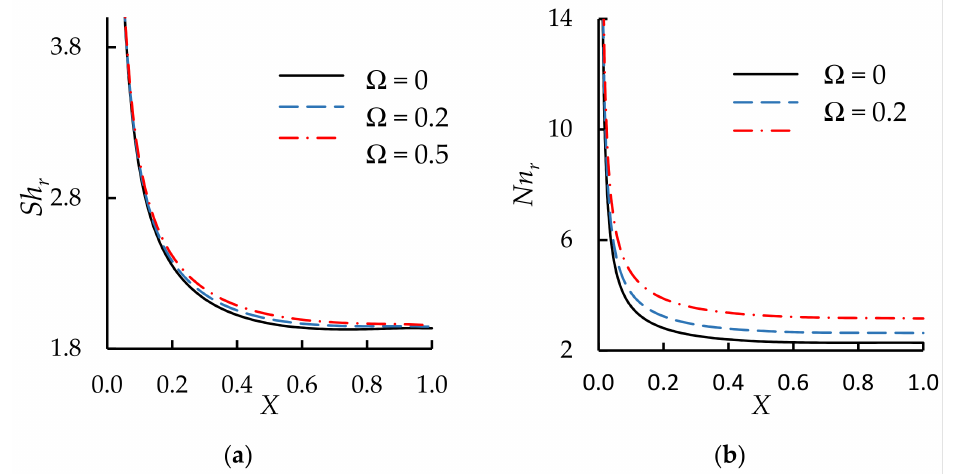
Figure 15. Effect of the difference in the density of the microorganisms, Ω , on ( a ) the reduced Sherwood number, Sh r , and ( b ) the rate of the transfer of microorganisms, Nn r, as a function of the position along the surface of the